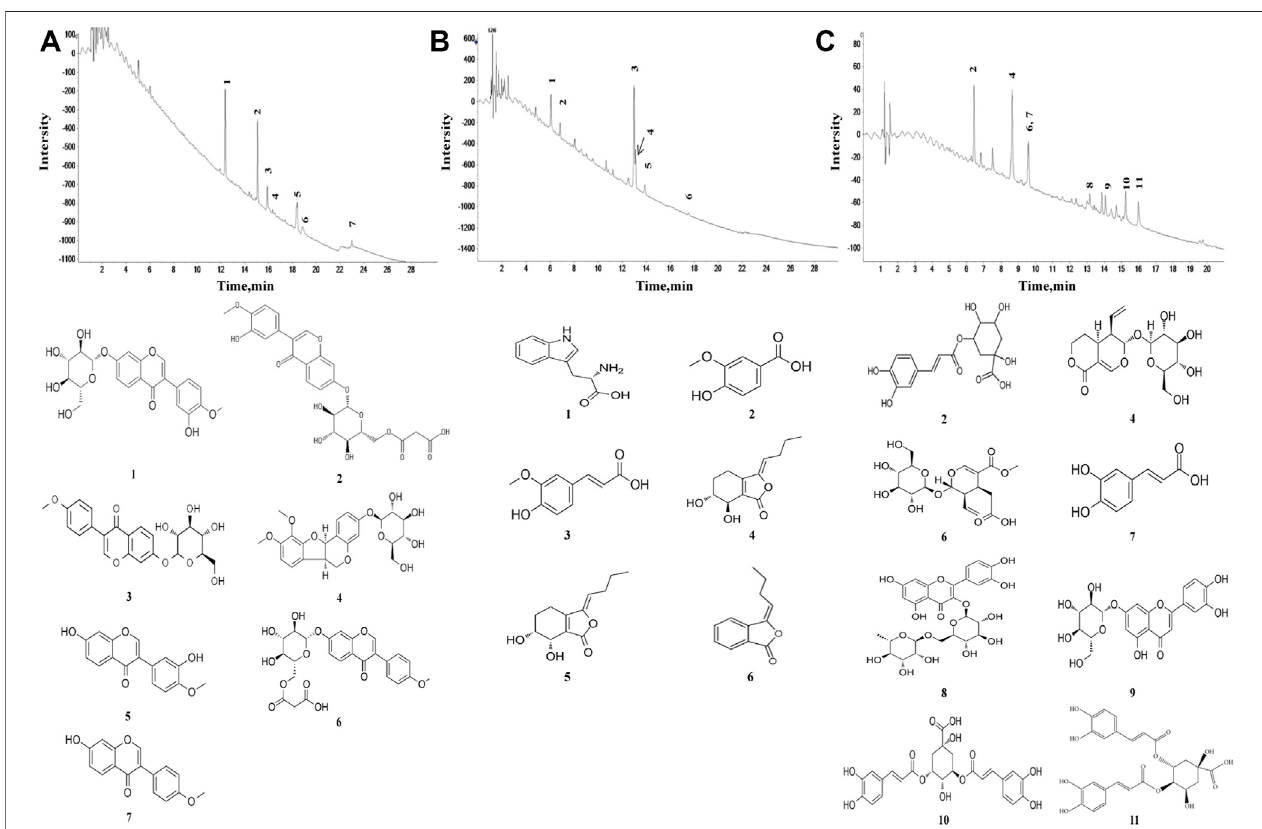
FIGURE 1 | Characteristics of pure compounds from the aqueous extract of R . astragali, R . angelicae sinensis , and C . lonicerae . The abscissa represents the retention time,and theordinate representsthe chromatographicpeak intensity. (A) HPLC-ESI/MS n total ion chromatogramof R . astragali and the molecular formulas